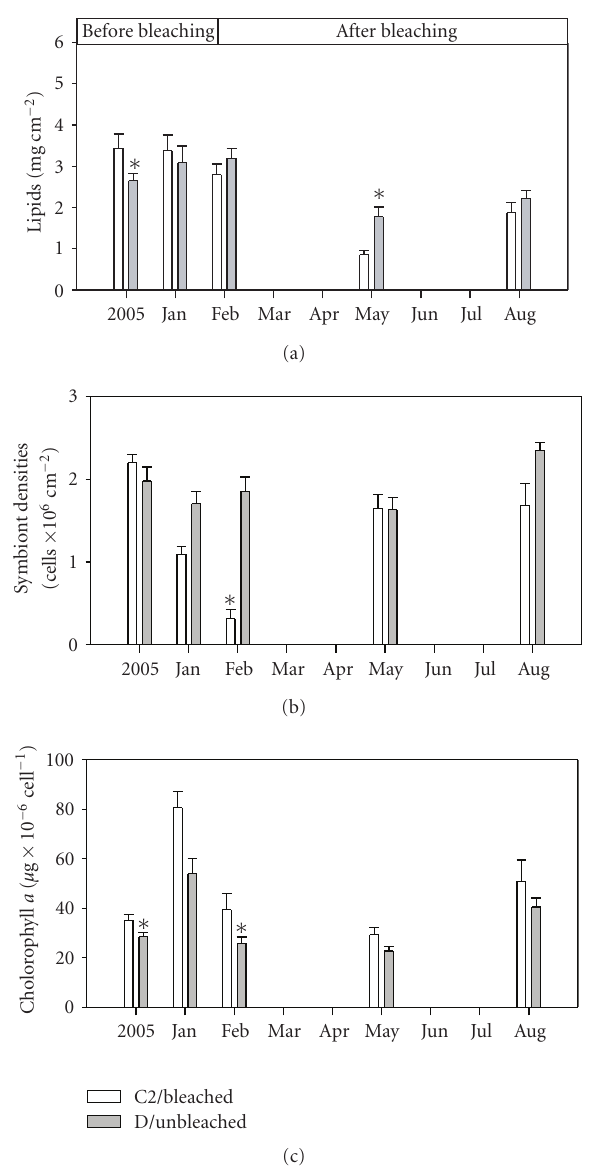
Figure 3: (a) Lipids, (b) chlorophyll a content, and (c) symbiont densities of Acropora millepora in the year before and after a bleaching event that occurred in February 2006. White bars represent colonies that had predominantly C2 symbionts before the bleaching and bleached white and grey bars represent colonies with predominantly D symbionts that did not bleach. Whisker bars above the bars represent the standard error of the mean. ∗ represent significant di ff